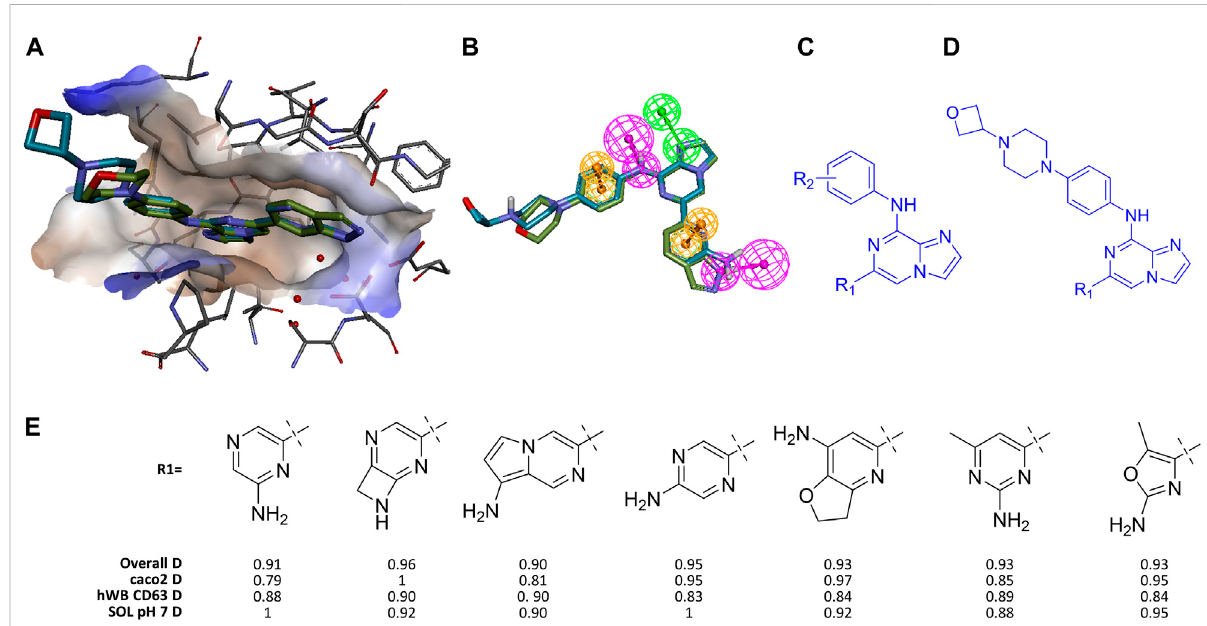
FIGURE 2 Identifying high value analogs of Entospletinib. (A) Entospletinib and lanraplenib aligned in SYK active site using pdbID 4puz and 6vov, respectively (receptor surface colored by hydrophobicity). (B) Same alignment with addition of fi ve shared pharmacophore features (HBD magenta, HBA green, ring aromatic orange; for more detail see 4puz_ento_ExVol2 in SI). (C) Substructure constraint for fi rst round of GTD iterations, R1 and R2 denote groups for enumeration. (D) Substructure constraint for second round of GTD iterations. (E) Representative GTD results with desirability